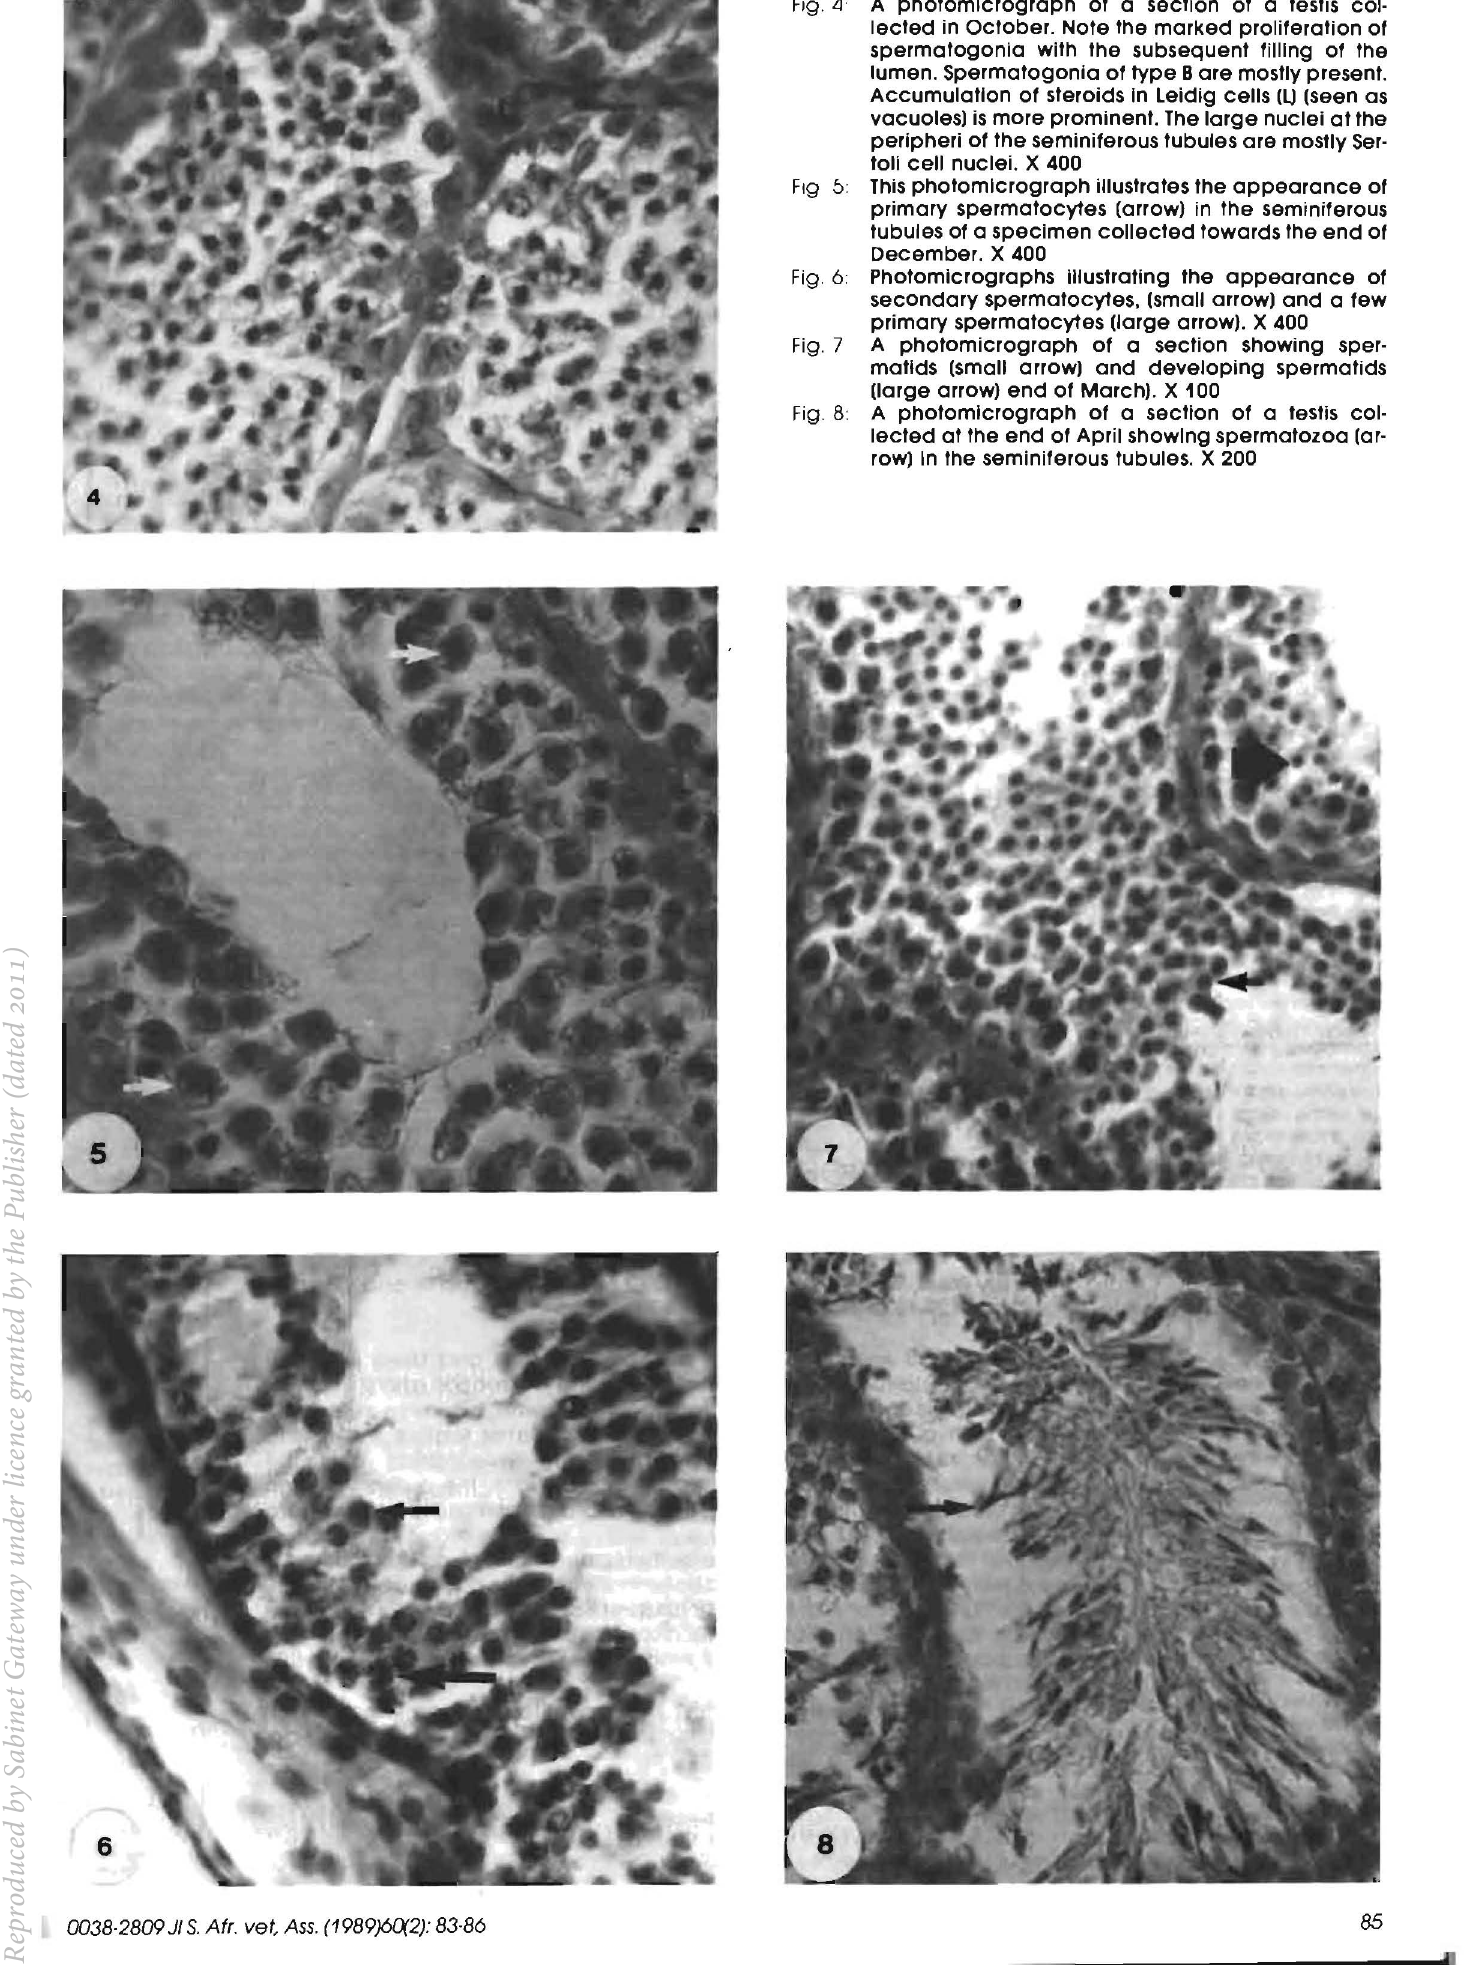
A photomicrograph of a section of a testis col lected in October. Note the marked proliferation of spermatogonia with the subsequent filling of the lumen. Spermatogonia of type B are mostly present. Accumulation of steroids In Leidig cells (U (seen as vacuoles) is more prominent. The large nuclei at the perlpheri of the seminiferous tubules are mostly Ser toli cell nuclei. X 400 Fig 0: This photomicrograph illustrates the appearance of primary spermatocytes (arrow) in the seminiferous tubules of a specimen collected towards the end of December. X 400 Fig. 6 Photomicrographs Illustrating the appearance of secondary spermatocytes. (small arrow) and a few primary spermatocytes (large arrow). X 400 Fig. 7 A photomicrograph of a section showing sper matlds (small arrow) and developing spermatids (large arrow) end of March). X 100 Fig. 8: A photomicrograph of a section of a testis col lected at the end of April showing spermatozoa (ar row) In the seminiferous tubules. X